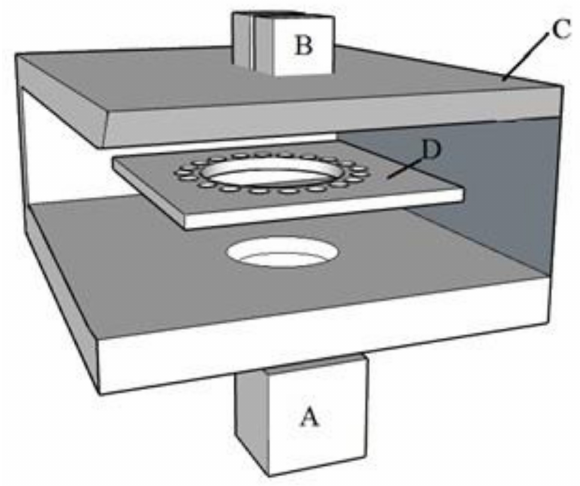
Figure 4. Sound Isolation Chamber used to house the fermentations and apply sound stimuli. The entire setup was placed inside a temperature control room at 28 ◦ C and allowed to acclimatise. ( A ) Low-frequency subwoofer. ( B ) Two middle-high frequency speakers. ( C ) Sound isolation chamber, cross-sectioned to show internal position of fermentations and the experimental 22 mm thick medium density fibreboards that act as soundproofing walls, lowering the internal sound intensity. ( D ) Position of the circular fermentation tube rack, which ensures equal sound intensity within each